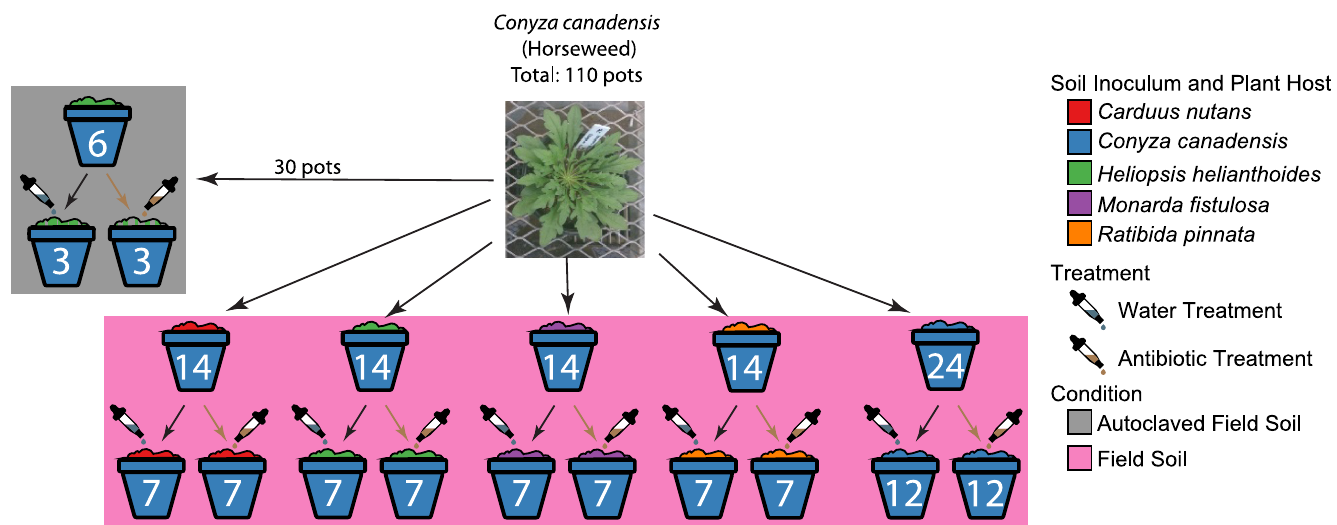
Fig 1. Illustrative description of study design. Only one species is represented in the picture; however, all plant hosts underwent the same manipulations. Seeds from each plant host (color of which plant host is depicted by color of the pot) were grown in soil collected from all plant hosts (color of source inoculum is depicted by the color of the soil). Soils were subjected to both an antibiotic treatment (depicted by color of liquid in the pipette) and autoclaved treatment (depicted by striations of the soil).